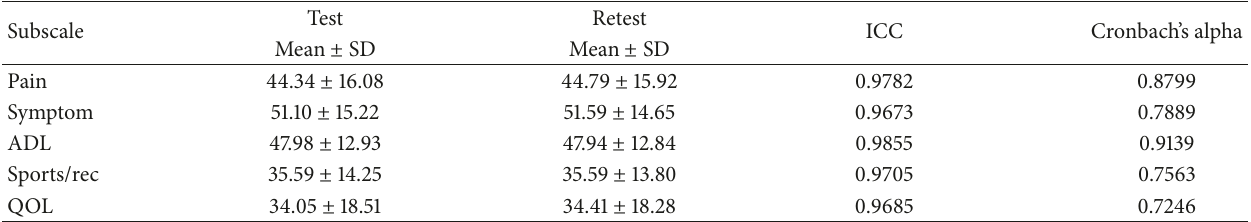
Table 2: Test-retest reliability and internal consistency of five KOOS subscales in Urdu version ( 𝑛 = 111 ). Subscale